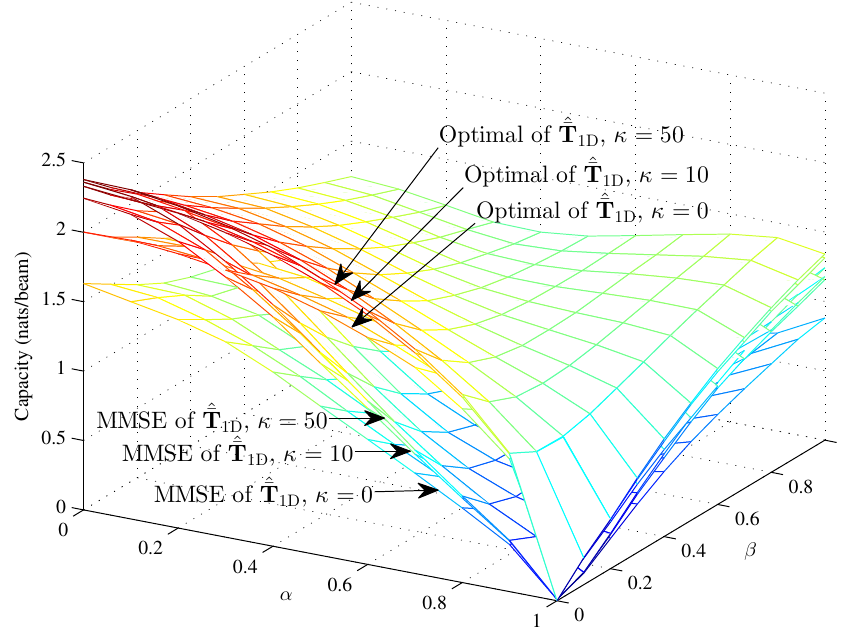
Figure 5. The optimal capacity and MMSE capacity of the modified hybrid 1D beams with γ = 10 and N = 100 ( κ = 0, κ = 10 and κ = 50) versus α and β .